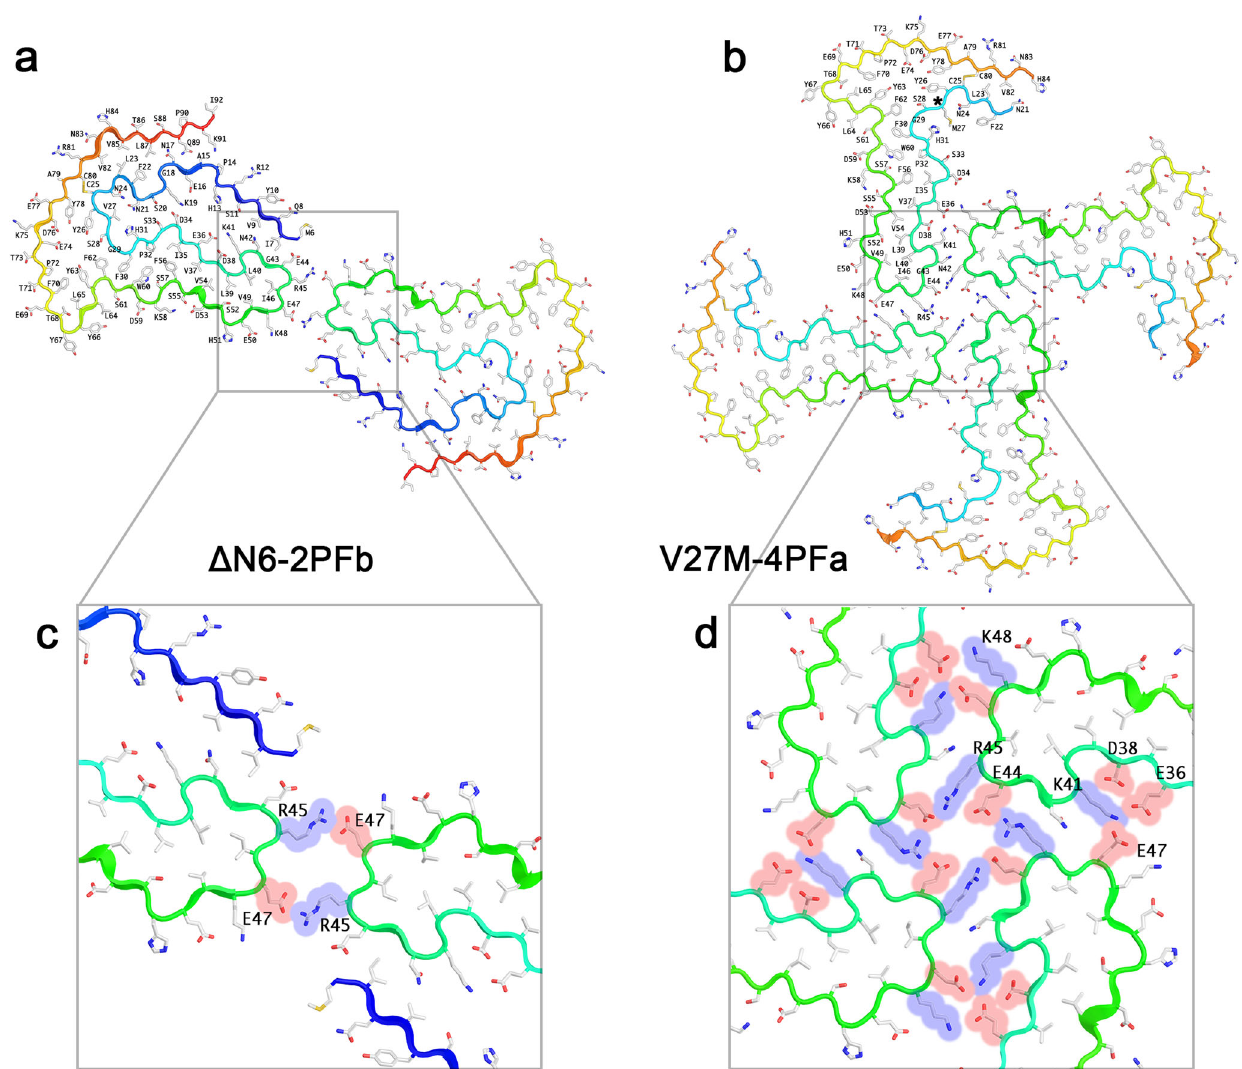
c , the proto fi laments are held together by a pair of salt-bridge interactions (R45/ E47),whilstfortheV27M-4PFastructure d ,E44/R45formthesaltbridges.InV27M- 4PFa,additionalsalt-bridgeinteractionsstabilisethe fi bril.For c , d ,thespace- fi lling footprint of the amino acid side chains involved in the intersubunit interfaces are